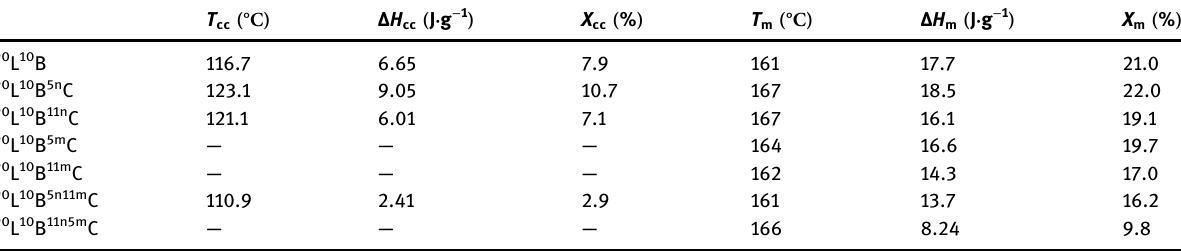
Table 6: Parameters derived from the second heating DSC scans